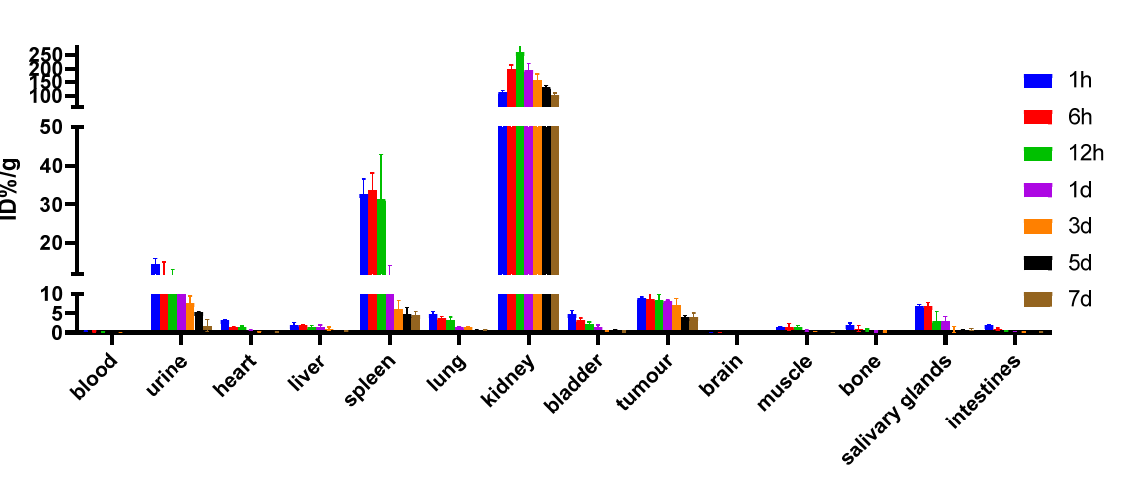
Figure 11. The distribution of 125 I-PSMA-7 in 22Rv1 tumor-bearing mice after injection of 5.55 × 10 5 Bq 125 I-PSMA-7 (values are expressed as the mean ± SD, n = 3). Table 1. The cpm per milligram of tumor and muscle (cpm/mg). . Background Tumor Muscle 4d 42 1739 45 7d 74 1404 32